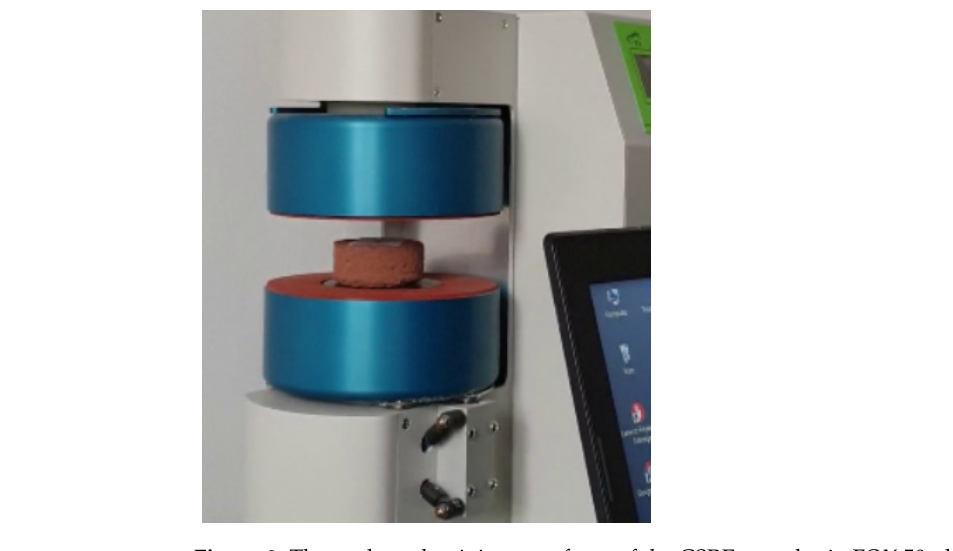
Figure 8. Thermal conductivity test of one of the CSRE samples in FOX 50 plate apparatus.